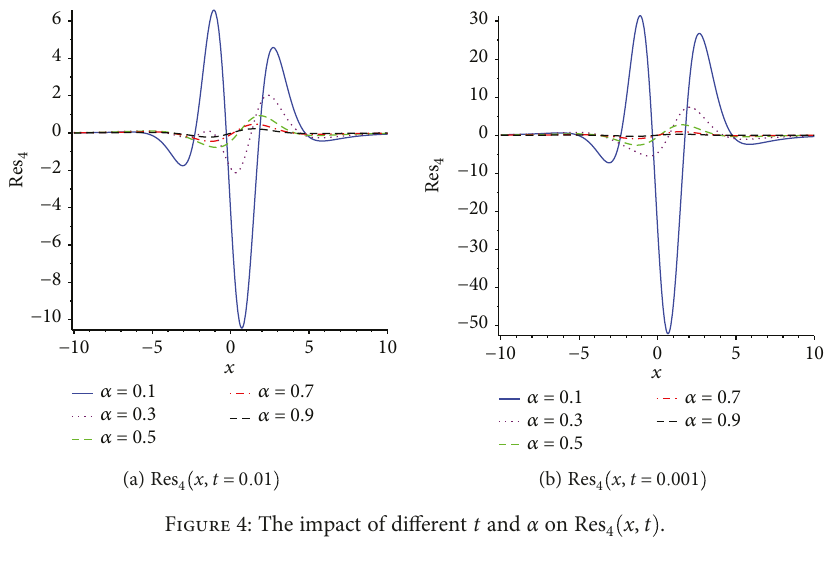
Figure 4: The impact of di ff erent t and α on Res